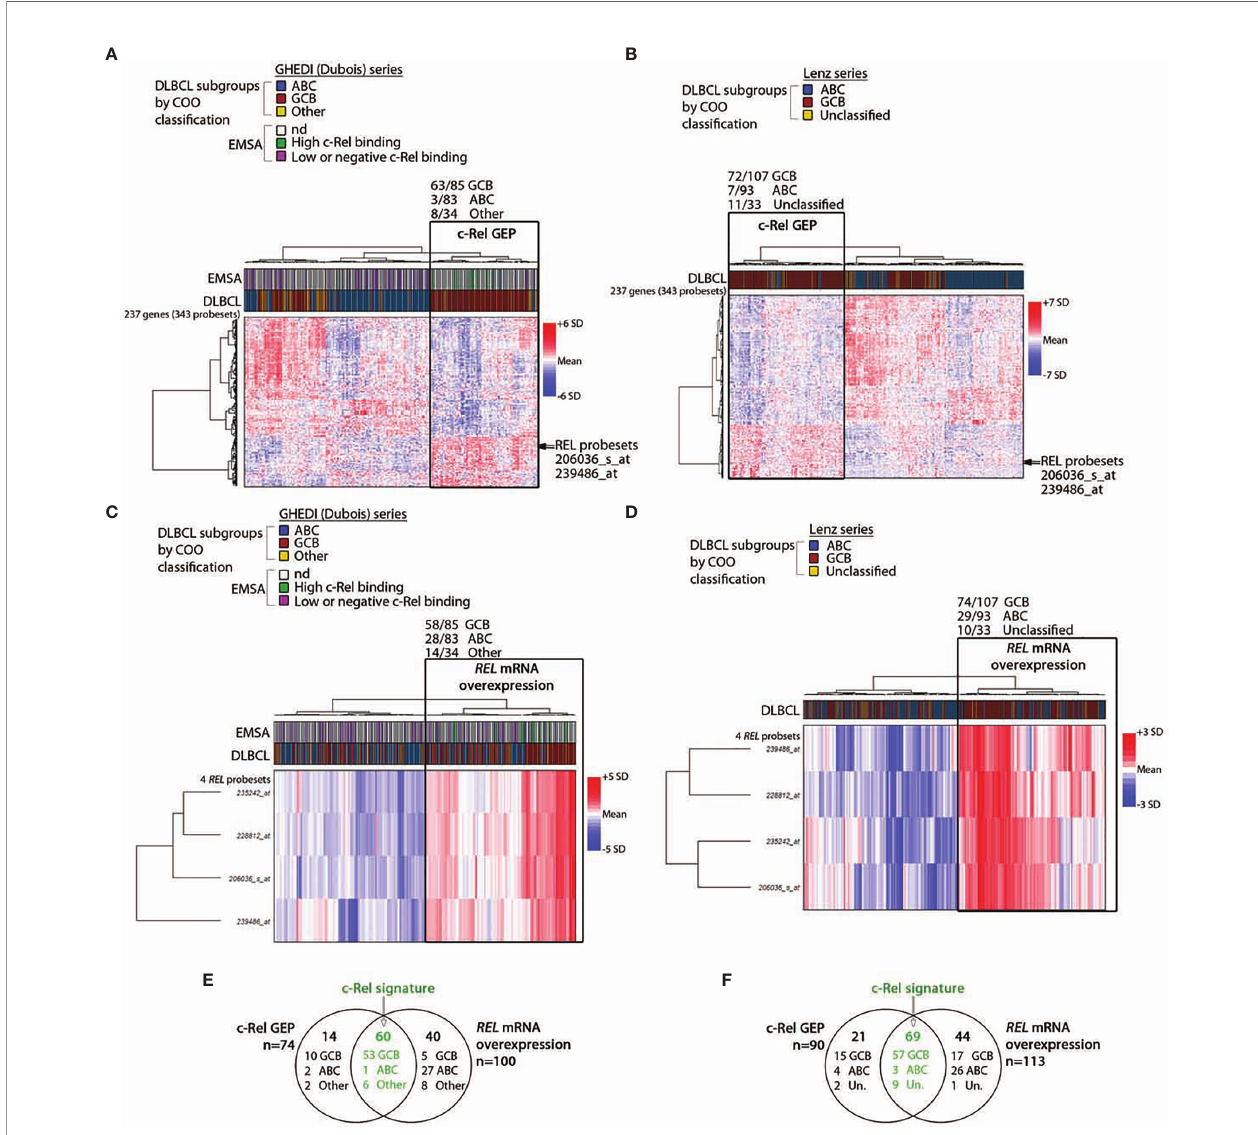
FIGURE 2 | c-Rel related transcriptomic signature of DLBCL patients. By comparing cases with high and low or negative c-Rel DNA-binding, a set of differentially expressed 343 probesets/237 genes with a fold change of two, and a p-value <0.05 was selected after LIMMA analysis of 66 DLBCLs from the GHEDI cohort for which EMSAs with super-shift were performed. (A, B) Unsupervised hierarchical Ward clustering of the whole GHEDI cohort and the Lenz series respectively with the 343 selected probesets. Lines and columns of the heatmap correspond to probesets and patients respectively. Up- and down-regulated genes are color coded according to the color scale shown on the right of the heatmap. The blue, red, and yellow color codes above the heatmap give the original COO ABC/GCB/Other and the ABC/GC/Unclassi fi ed diagnosis of the GHEDI and Lenz series respectively. Position of the c-Rel probsesets on gene clusters is indicated by an arrow. For the GHEDI series, high and low c-Rel binding cases by EMSA are color coded in green and purple respectively (nd: EMSA not done). The branch of patients with the c-Rel gene expression pro fi le (c-Rel GEP) is highlighted by a black rectangle on each heatmap. Number of COO cases within this speci fi c branch is indicated at the top of the black rectangle. (C, D) Unsupervised hierarchical Ward clustering of the entire GHEDI cohort and the Lenz series respectively with c-Rel probesets. Orientation of the heatmap and color codes are the same as in panel (A) The branch of patients overexpressing REL mRNA is highlighted by a black rectangle on each heatmap. Number of COO cases within this speci fi c branch is indicated at the top of the black rectangle. (E, F) Venn diagram showing the overlap of patients between c-Rel GEP and REL mRNA overexpression corresponding to c-Rel signature (in green). Number of cases in each group is indicated. Un., unclassi fi